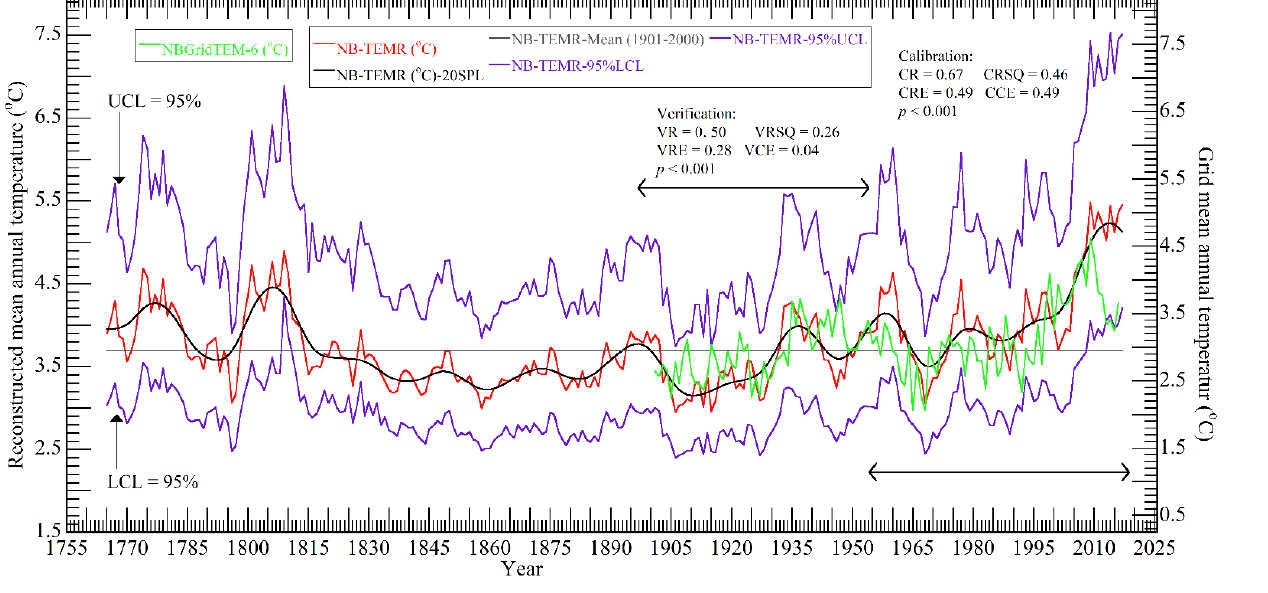
Figure 7. NB-TEMR (red line with grey spline) and NBGridTEM-6 (aquamarine line). Calibration and validation regression metrics are shown for absolute data only. Reconstruction data has been filtered by 20-year Low Pass Filtered smoothing. Upper and lower 95% confidential level (UCL95% and LCL95%—purple lines). Note: CR—calibration correlation; CRSQ—calibration